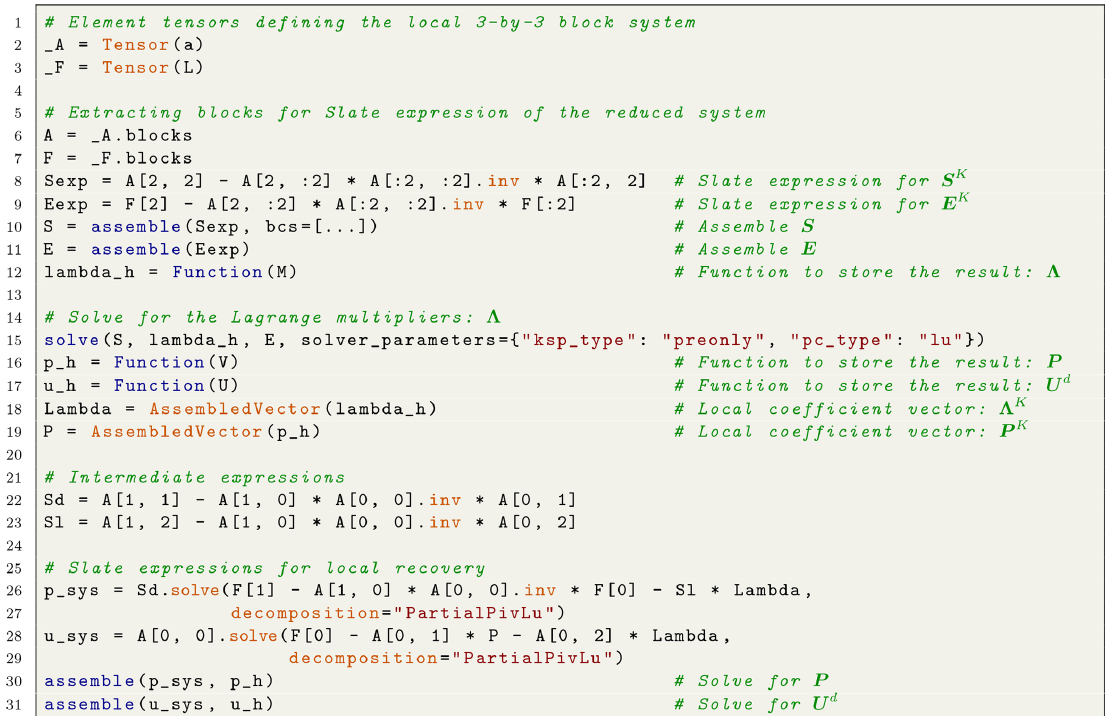
Figure 2. Firedrake code for solving Eq. (44) via static condensation and local recovery, given UFL expressions a , L for Eqs. (41)–(43). × V h × M h are indexed by 0, 1, and 2, respectively. Lines 8 and 9 are symbolic expressions for Eqs. (46) Arguments of the mixed space U d h and (47), respectively. Any vanishing conditions on the trace variables should be provided as boundary conditions during operator assembly (line 10). Lines 26 and 28 are expressions for Eqs. (48) and (49) (using LU). Code generation occurs in lines 10, 11, 30, and 31. A global linear solver for the reduced system is created and used in line 15. Configuring the linear solver is done by providing an appropriate Python dictionary of solver options for the PETSc